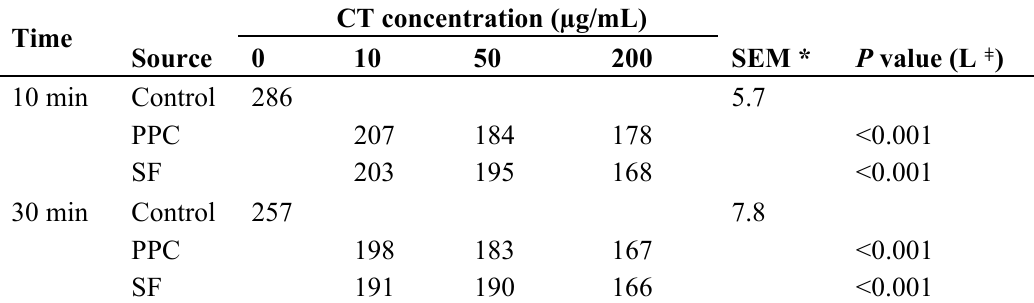
Table 2. Relative fluorescence values of liposome and 1- N -phenylnaphthylamine (NPN) mixtures after addition of purple prairie clover (PPC; Dalea purpurea Vent.) and sainfoin (SF; Onobrychis viciifolia ) condensed tannins